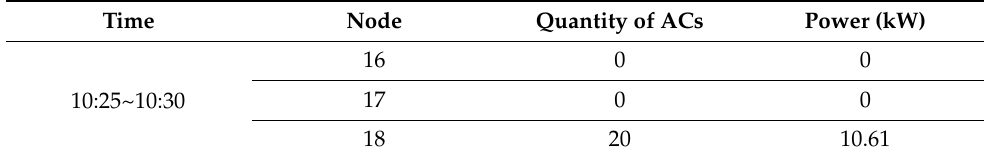
Figure 11. The room temperatures of node 18. Table 2. The over-voltage regulation process of the successive voltage regulation